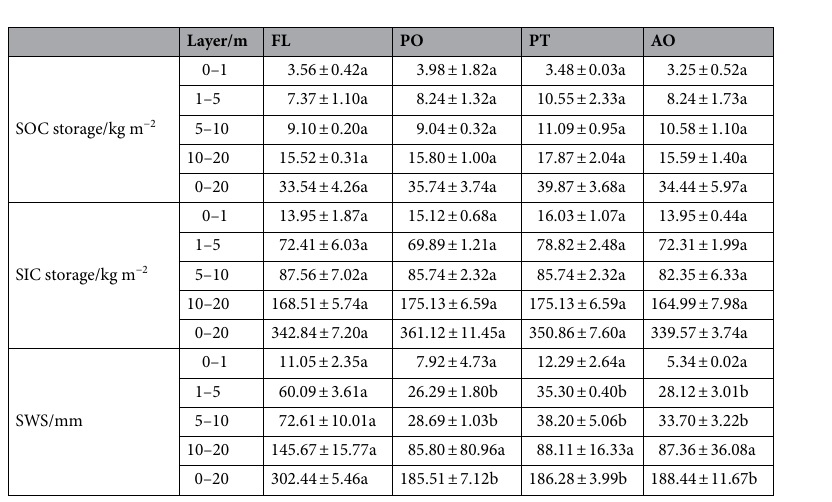
Table 2. Soil organic carbon (SOC) storage, soil inorganic carbon (SIC) storage and soil water storage (SWS) (mean ± SD, n = 2) of different soil layers for different vegetation types. Different upper and lower-case letters indicate significant differences at p < 0.05 among vegetation types and averaged layers, respectively. FL farmland, PO Platycladus orientalis (Linn.) Franco, PT Pinus tabulaeformis Carr., AO apple